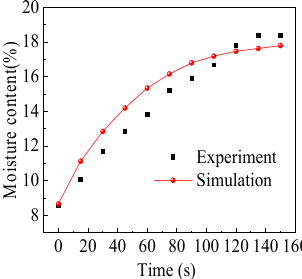
Figure 4. The experimental rewetting box.